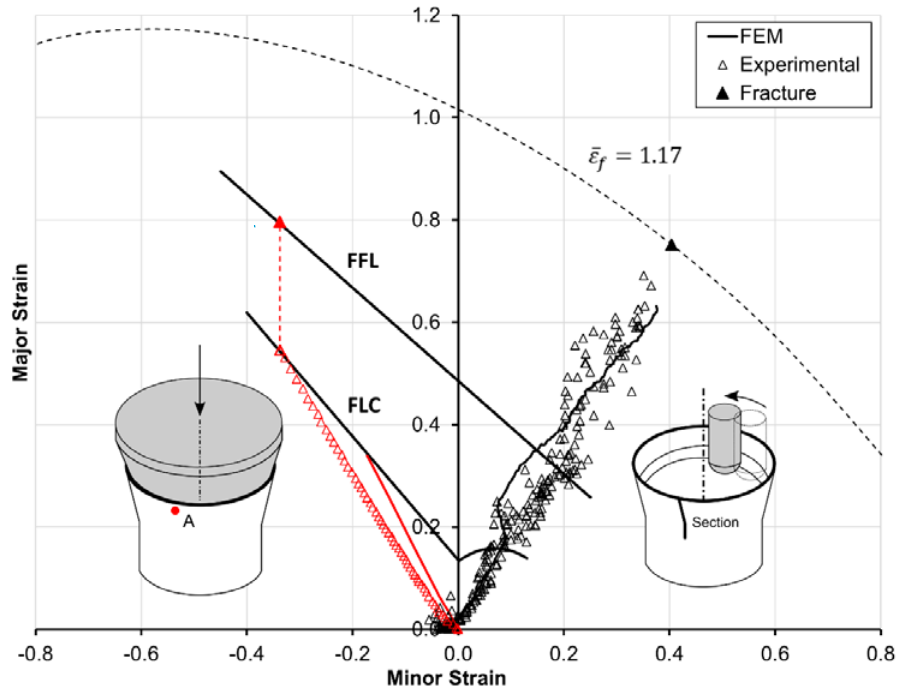
Figure 8. Experimental vs. finite element predicted in-plane strains for conventional tube expansion with a rigid tapered conical punch (red markers) and incremental tube expansion with a single point hemispherical tool after eight forming stages (black markers).